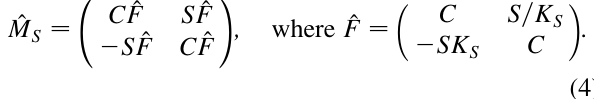
(cid:3) 10 mrad for the SiD, c